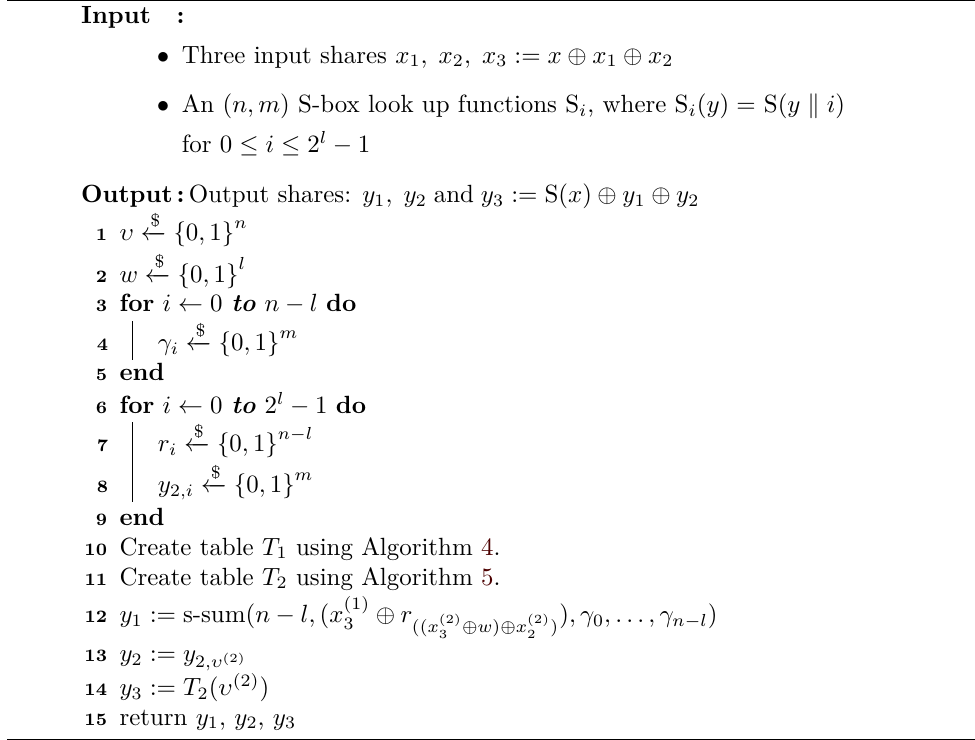
Algorithm 6: Second-order lookup table compression